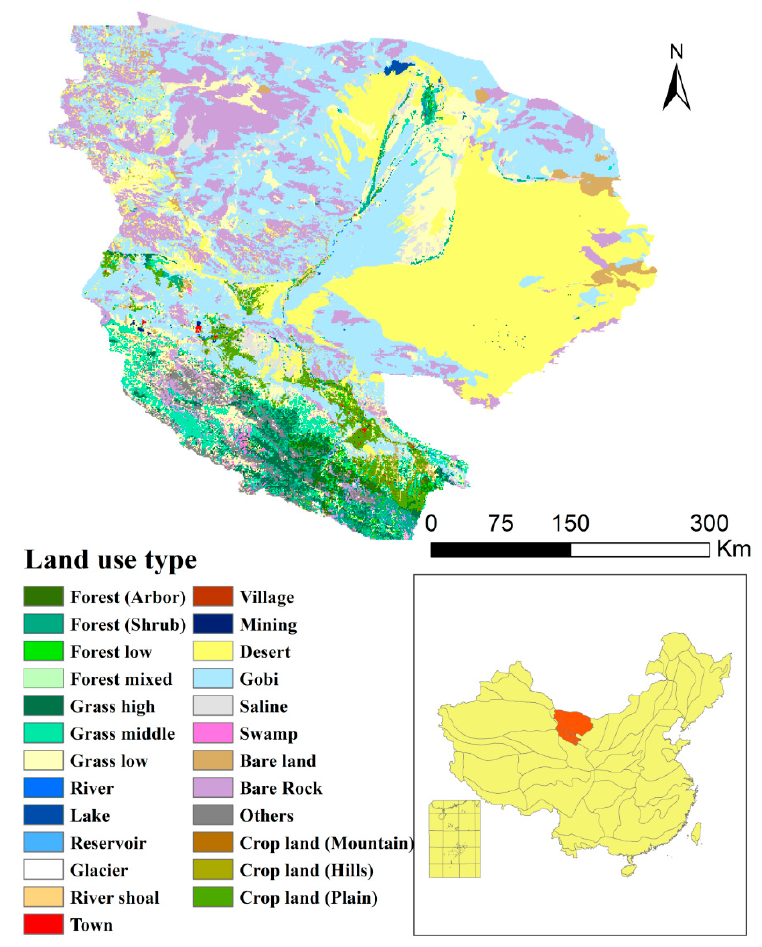
Figure 2. Location and land use types in 2005 of the Heihe River Basin.